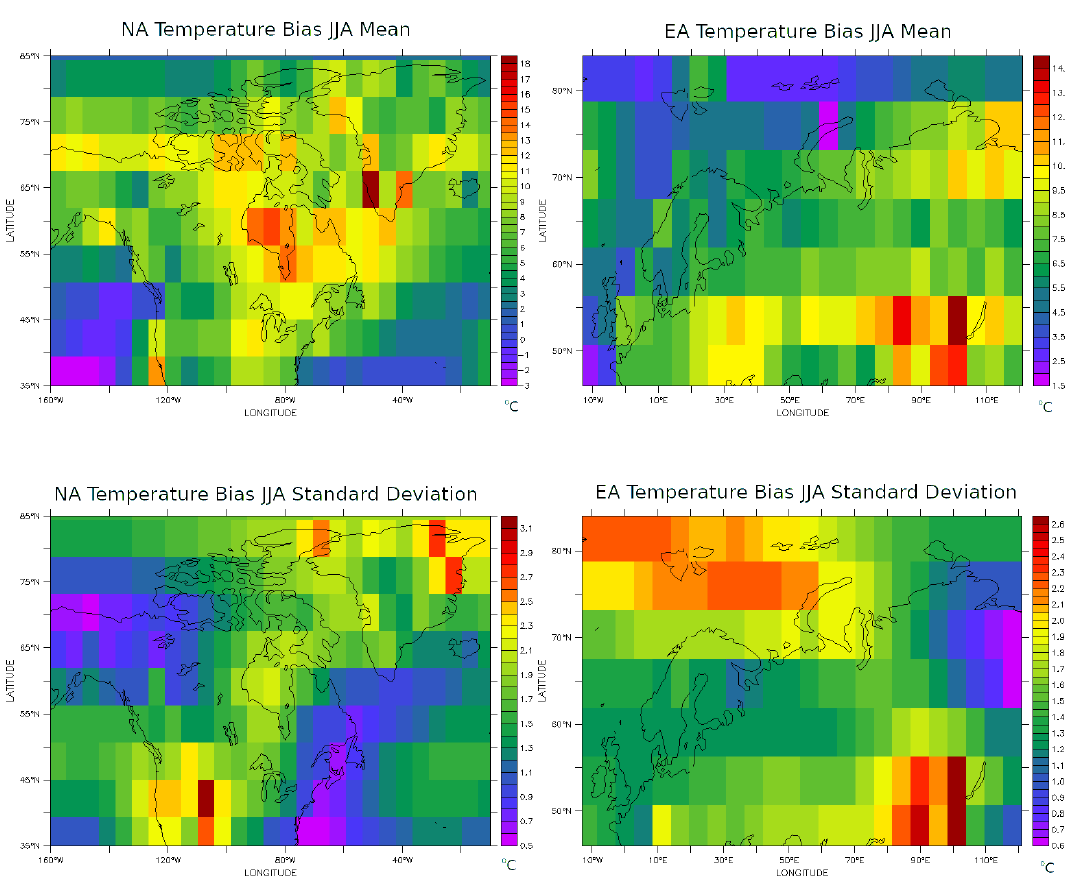
Figure 14. Mean present-day summer (June–July–August) temperature bias of the reduced 55-member sub-ensemble relative to the NCEP reanalysis climatology (Kalnay et al., 1996). Climatological temperatures from LOVECLIM simulations were adjusted for elevation differ- ences between the two datasets using the LOVECLIM-derived vertical surface temperature lapse rate for each ensemble